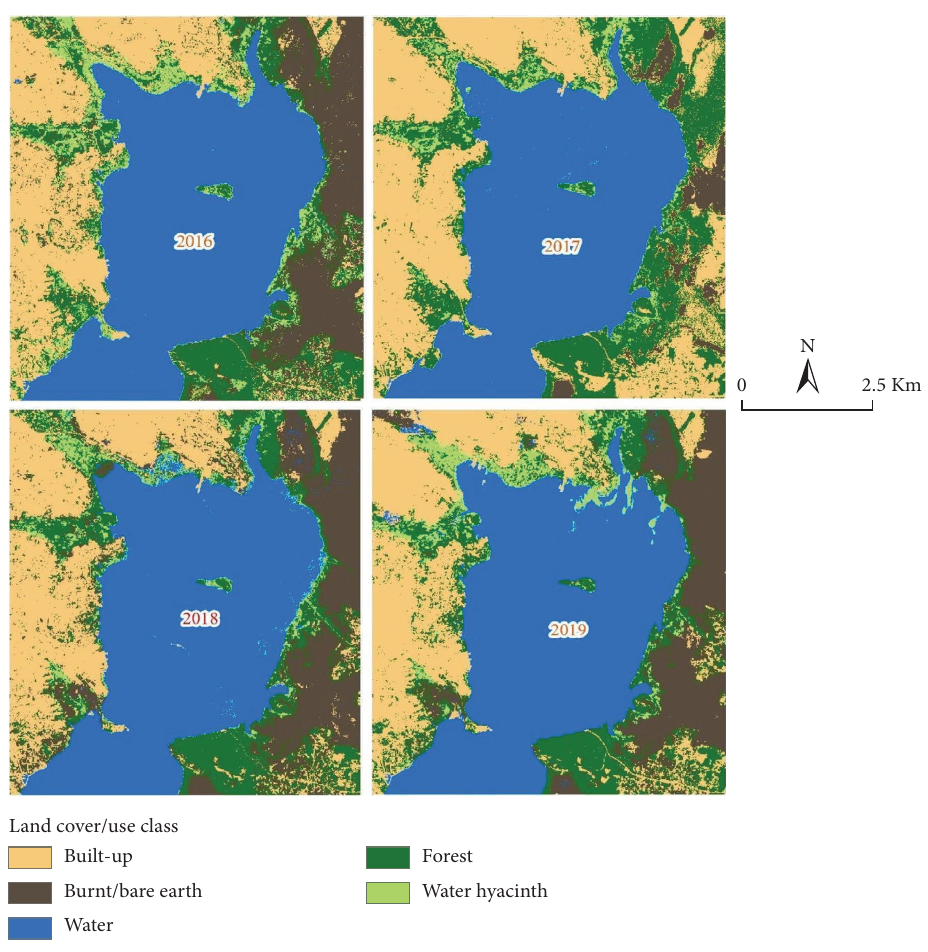
Figure 4: Water hyacinth relative extent in the Murchison Bay between 2016 and